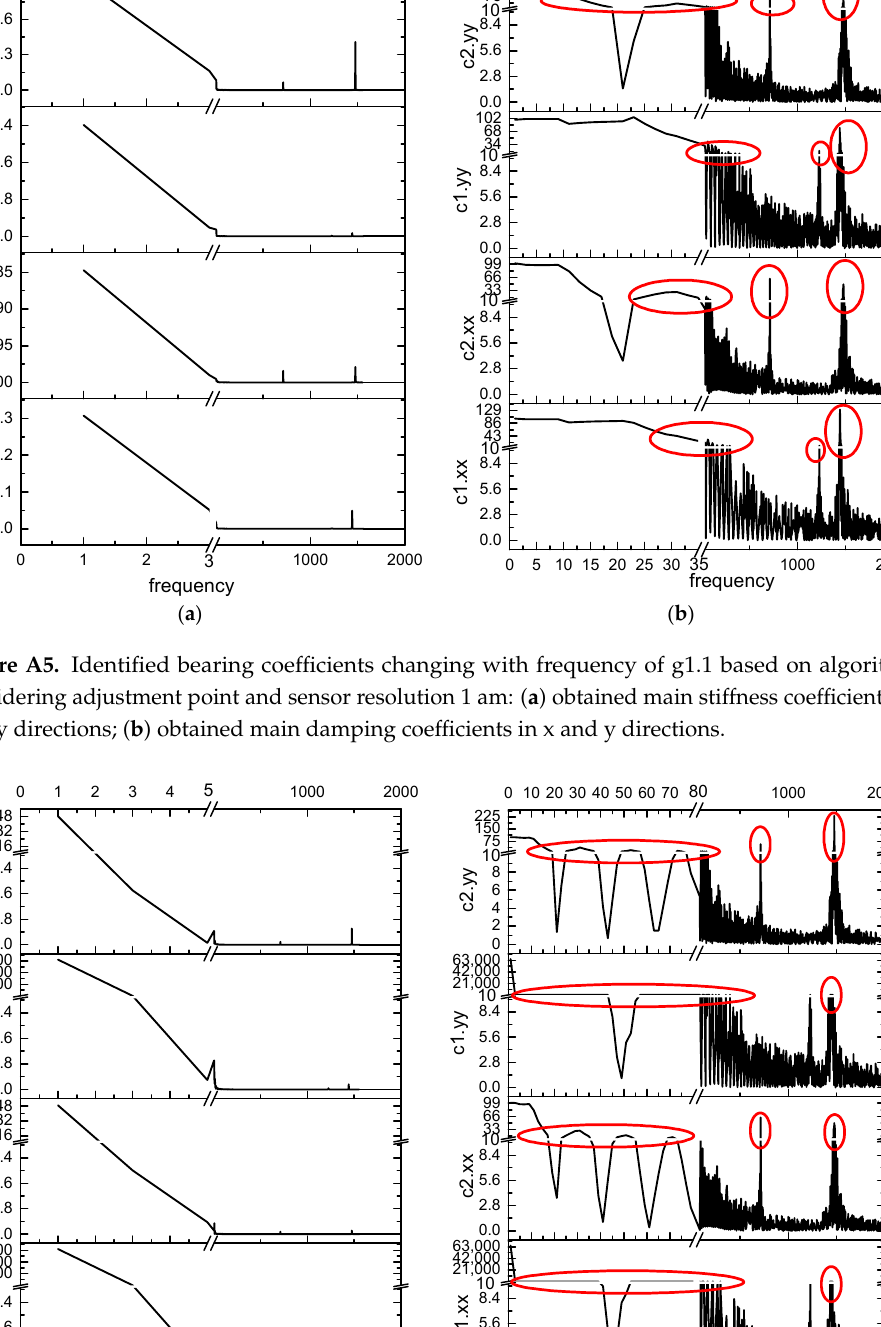
(2) Simulation of g1.1.